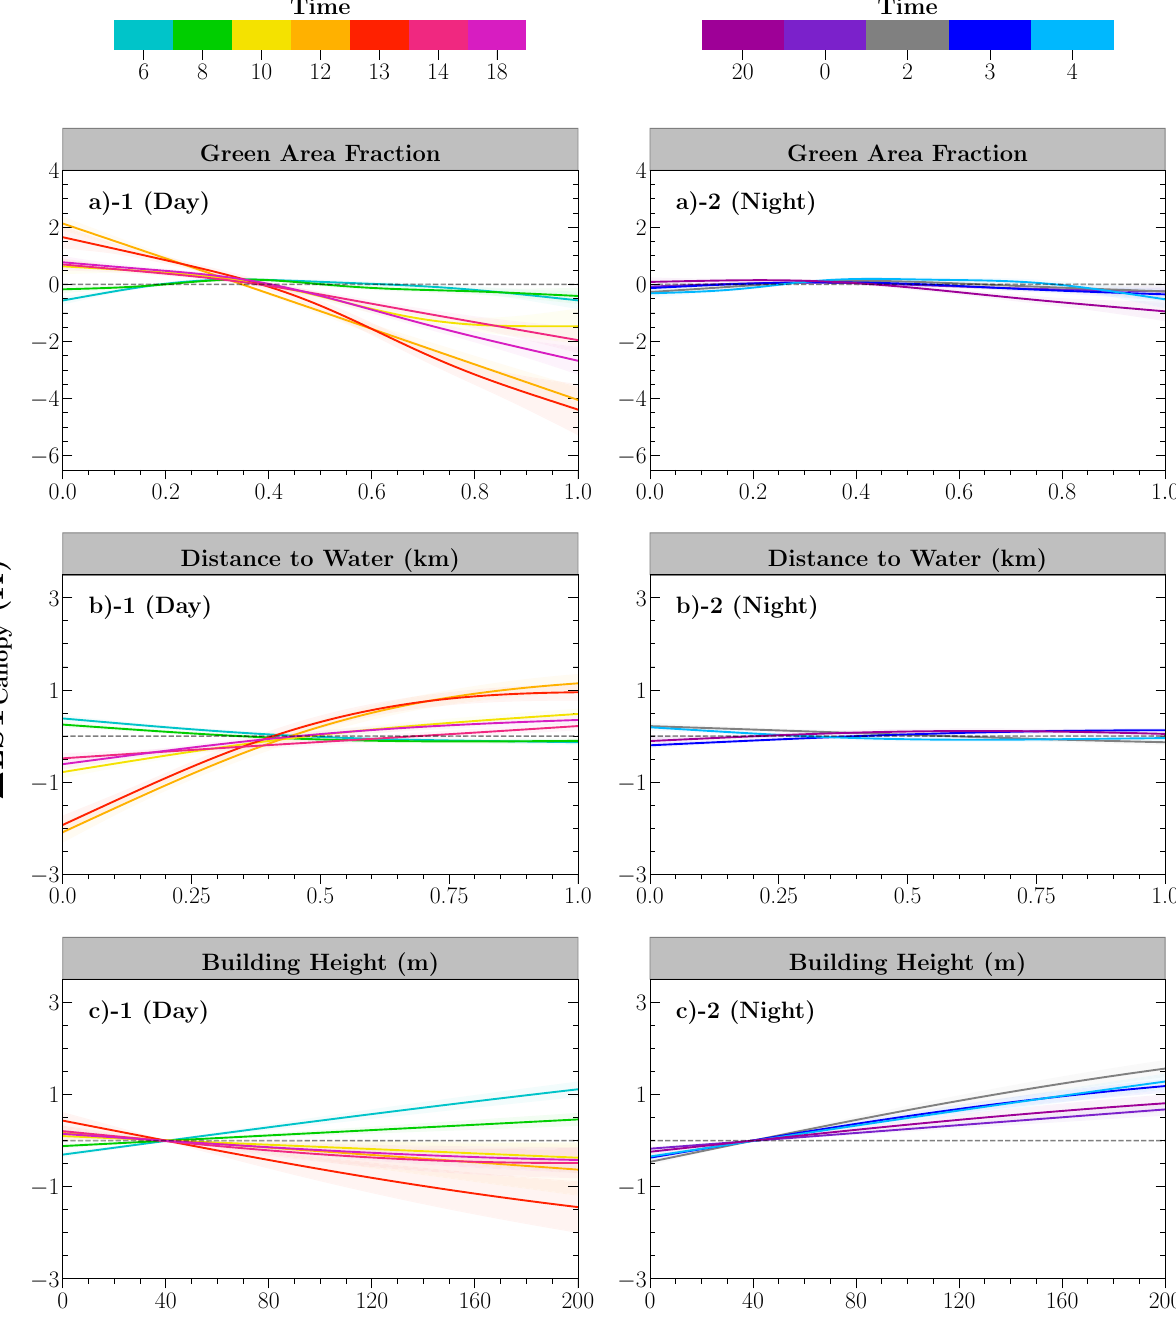
Figure 3. Estimated effects of urban greenspaces, distance to waterbodies, and building height on the spatial and diurnal patterns of (cid:31) LST Canopy ; the left column is for daytime hours and the right column is for nighttime hours. Domain mean LST was used as a reference value for (cid:31) LST Canopy . (cid:31) LST Canopy equals zero is indicated as black dashed lines. The shaded regions illustrate the confidence interval 95% of GAMs